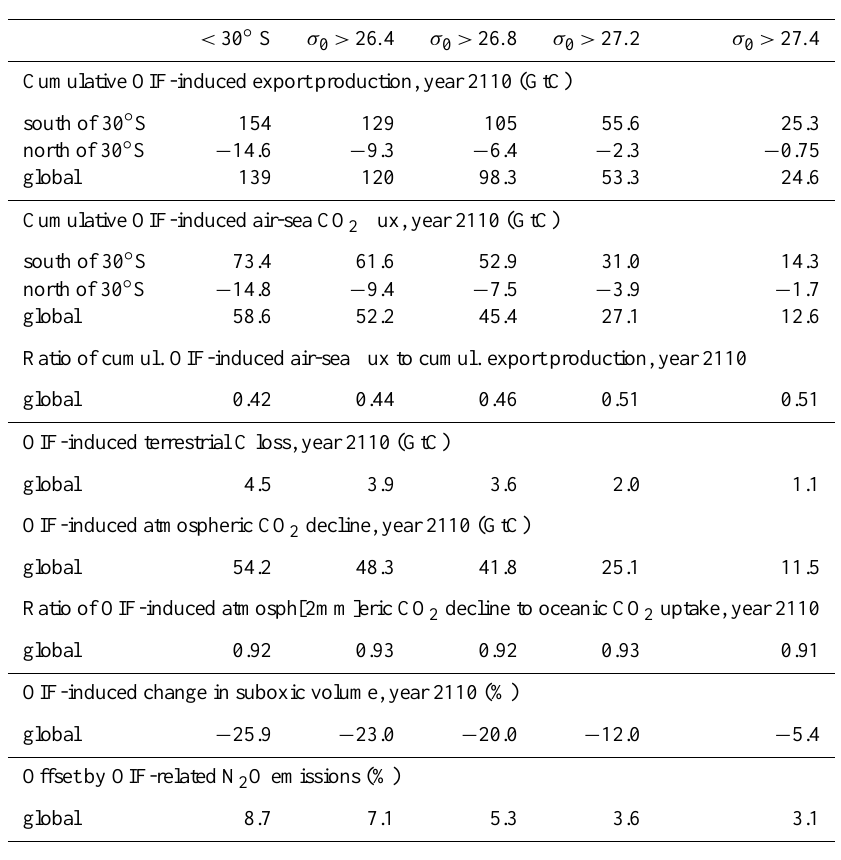
Table 2. Sensitivity to fertilized surface